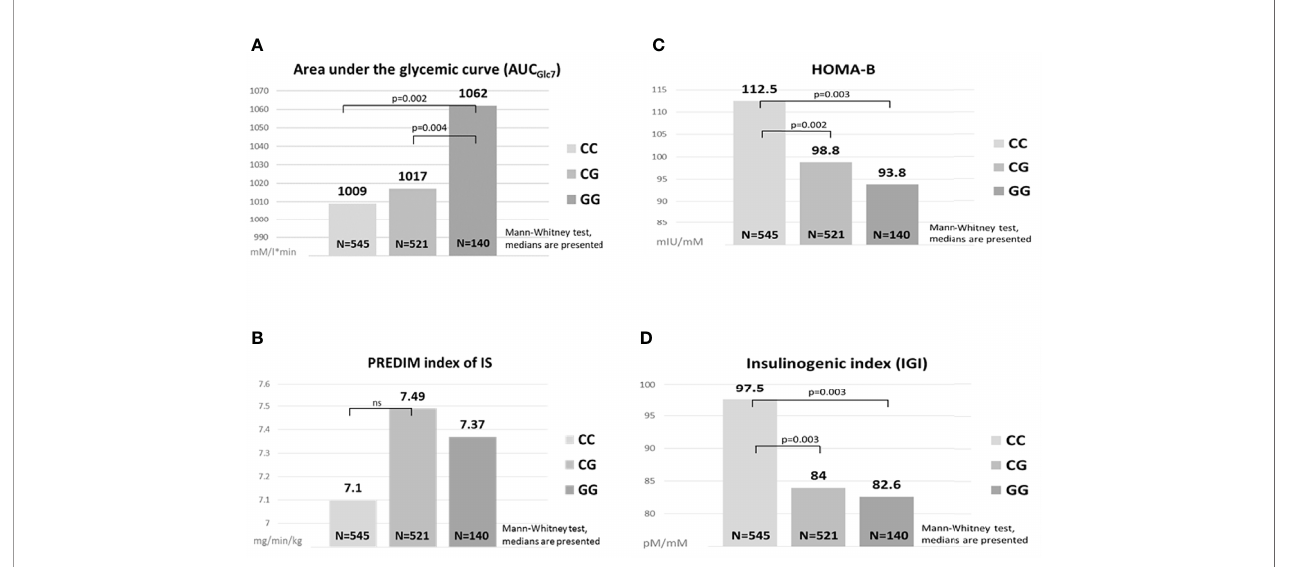
FIGURE 1 | Comparisons of glucose metabolism between the MTNR1B genotypes. Area under the glycemic curve (A) , HOMA-B (C) , PREDIM index of IS (B) , Insulinogenic index (D) . ns, not signi fi cant.